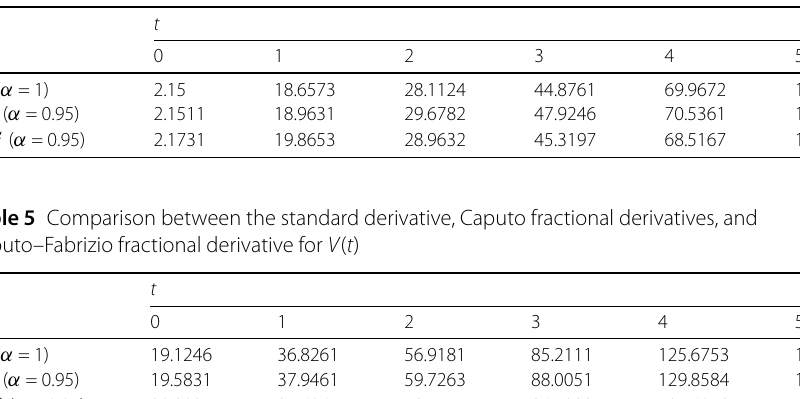
Table 4 Comparison between the standard derivative, Caputo fractional derivatives, and Caputo–Fabrizio fractional derivative for R ( t ) t 0 1 2 3 4 5 D α ( α = 1) 2.15